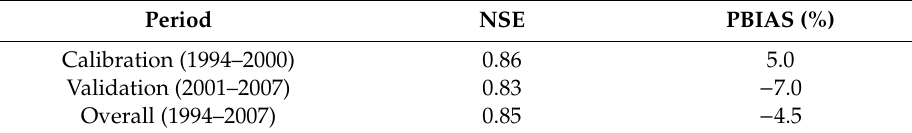
Table 2. The model calibration and validation results for the Hailuogou basin [39].